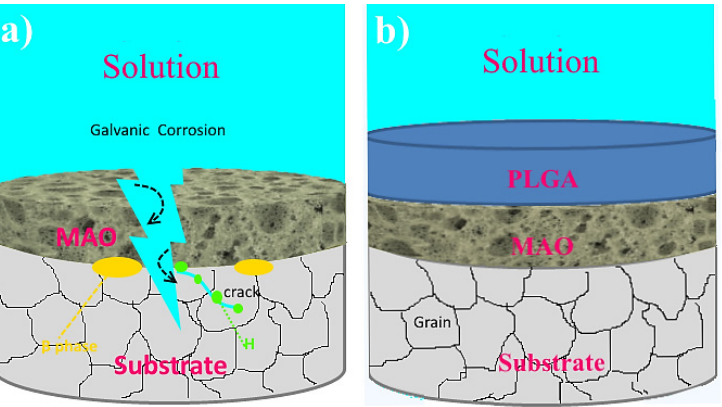
Figure 4. Schematic of the corrosion behavior for ( a ) MAO; ( b ) MAO+PLGA coated. Reprinted with permission from [43]; Copyright 2019 Elsevier.